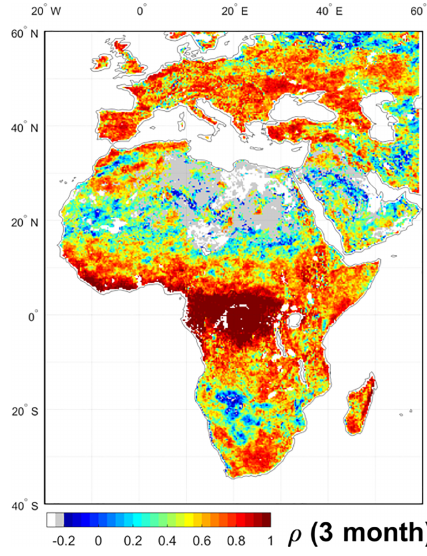
Figure 8. Pearson’s correlation between anomaly in 3-month ET totals as estimated by ALEXI-IR and ALEXI-MW, calculated at 0.25 ◦ resolution. White areas have no data; grey areas are masked because the standard deviation in the 3-month anomaly was below 8mm/3 months in both